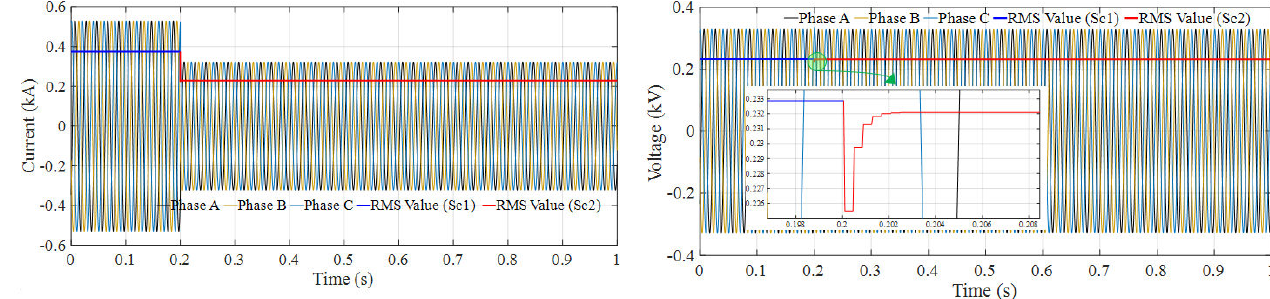
Figure 22. Voltage and current signals at the transformer secondary side for scenario 1 and scenario 2.